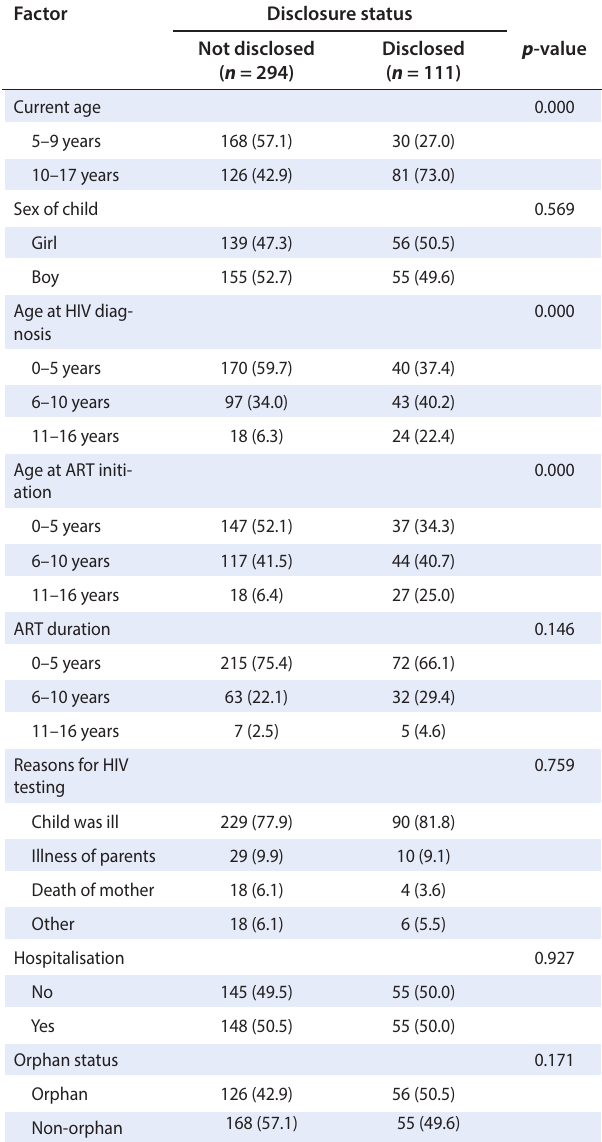
Table 2: Demographic and clinical characteristics of HIV infected children by disclosure status Factor Disclosure